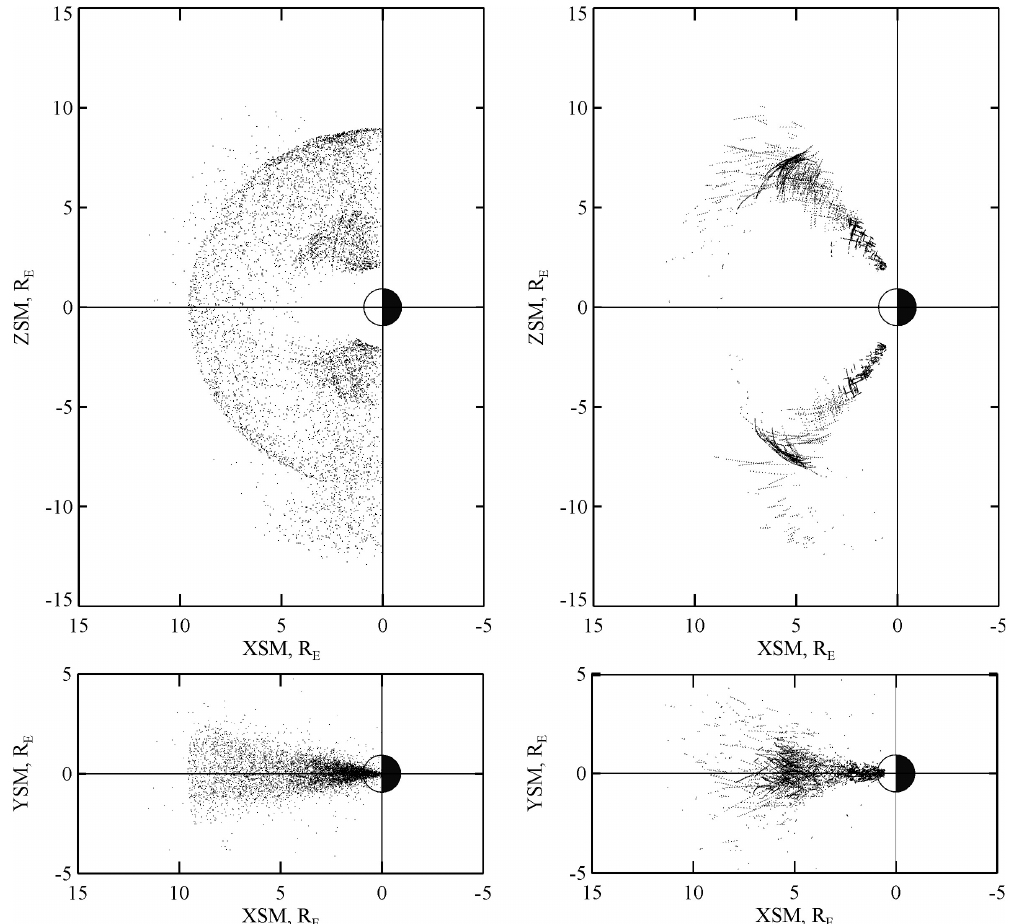
Fig. 4. Distribution of Polar/Cluster near-cusp data obtained using the “sliding funnel” method, in projection on the XSM-ZSM (above) and XSM-YSM (below) planes. Left panels: cumulative set of data points corresponding to all 201 values of the footpoint latitude shift in the range − 10 ◦ ≤ 13 ≤+ 10 ◦ (total number of records N =72516). Right panels: a subset of the cumulative set, corresponding to a single value 13 = 0 (total number of records N